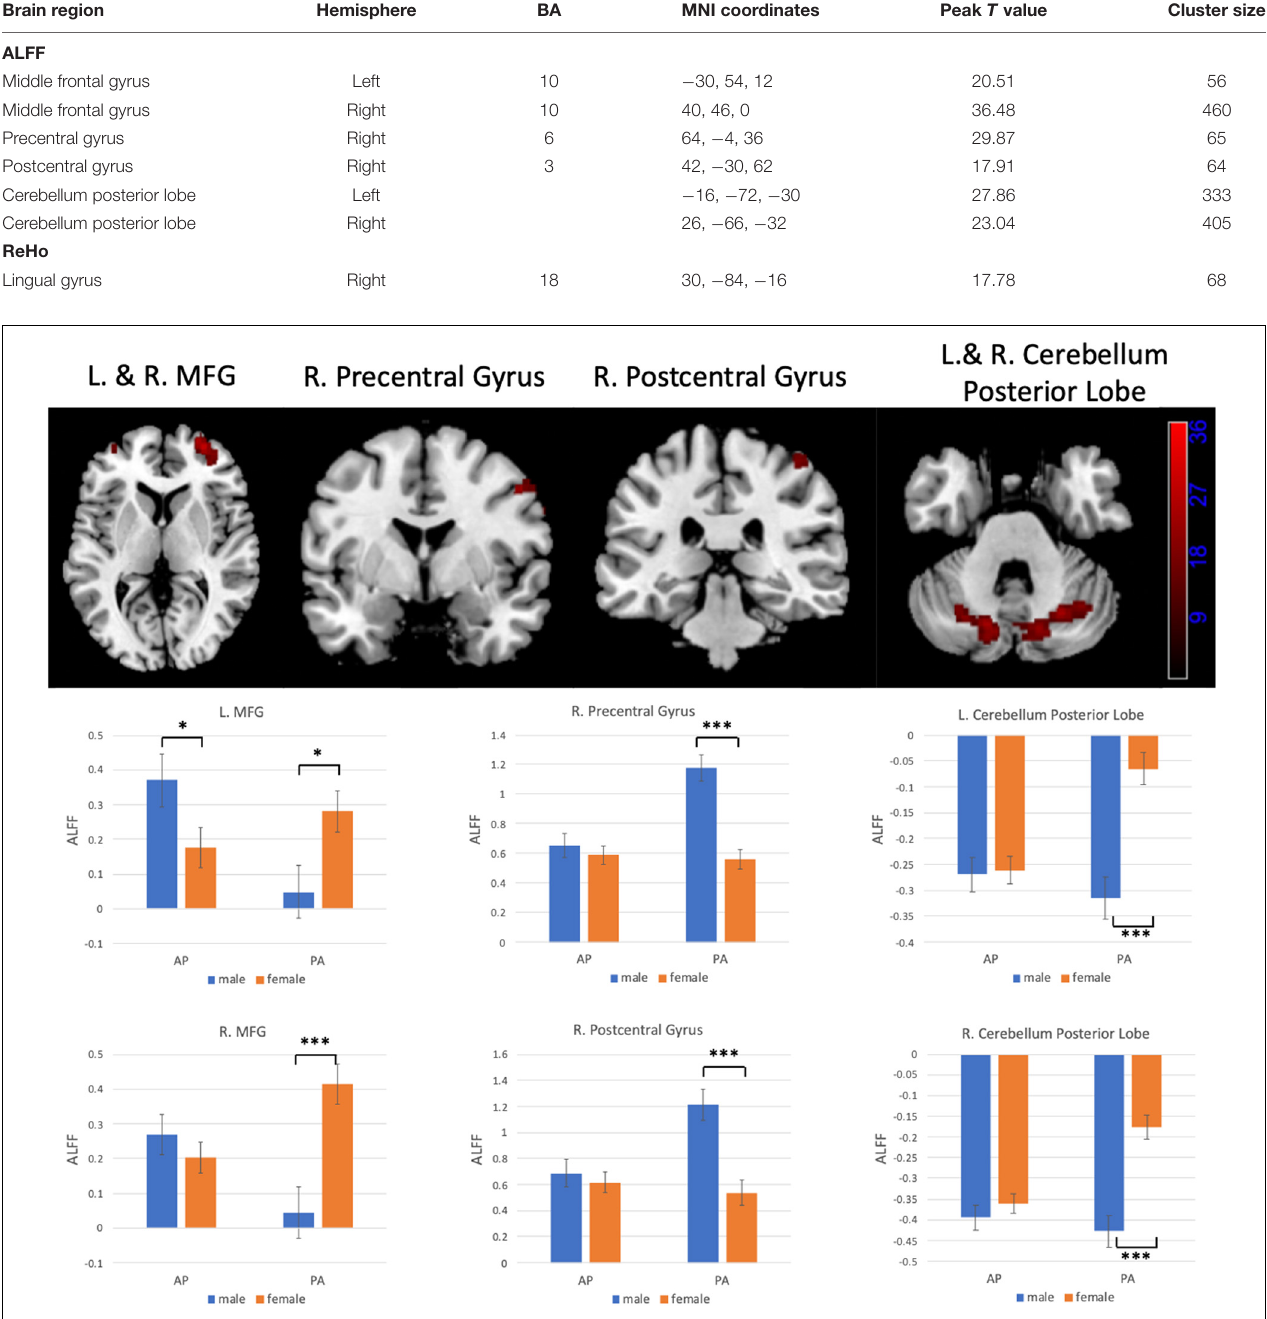
TABLE 4 | Regions influenced by the interaction effect between gender and PE direction (AP vs. PA) for ALFF and ReHo. Brain region Hemisphere BA MNI coordinates Peak T value Cluster size